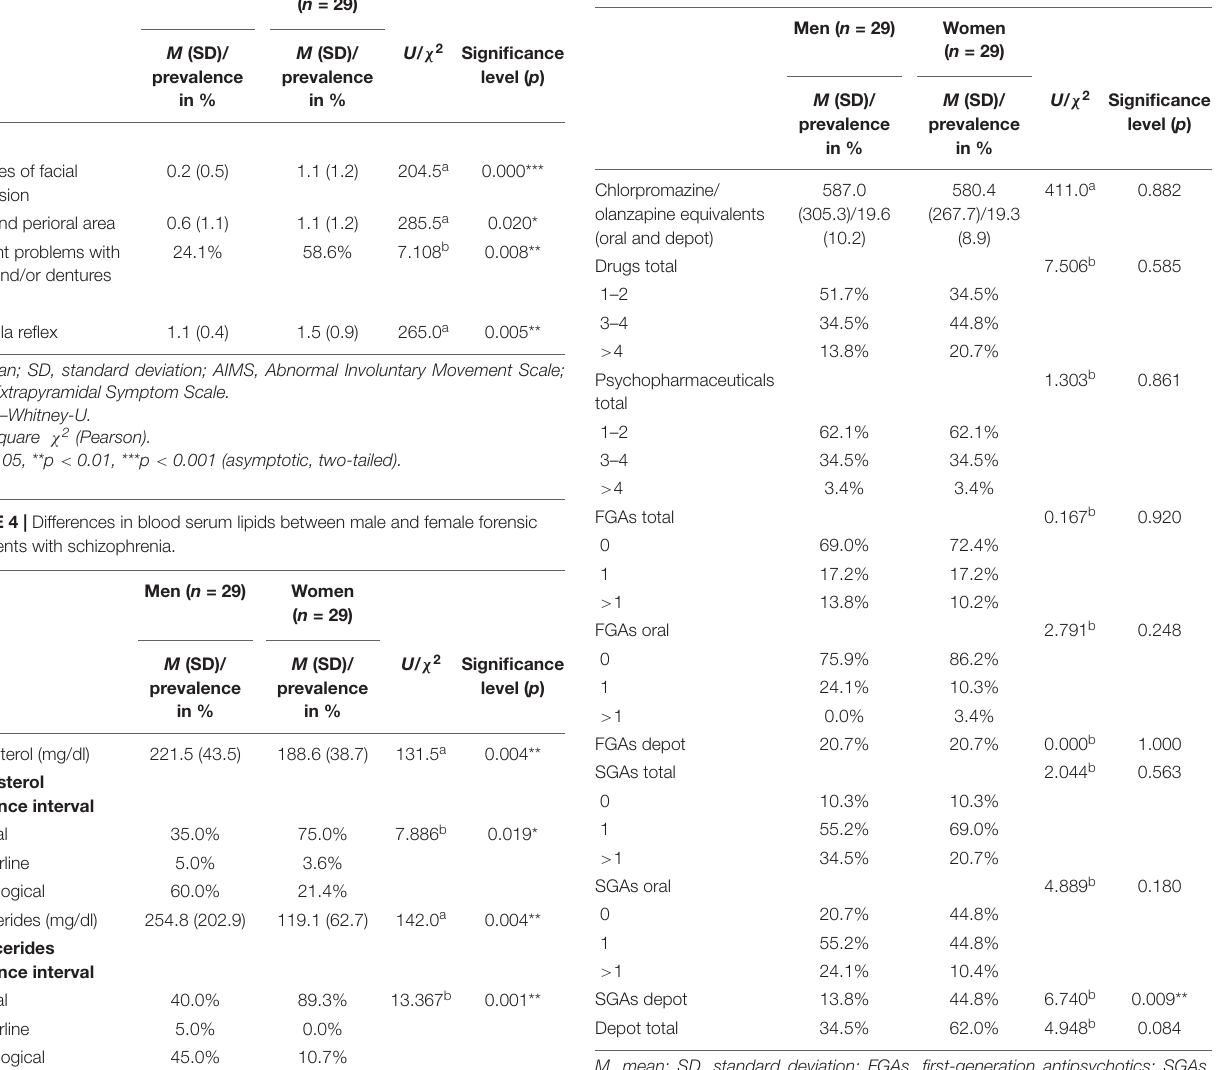
TABLE 5 | Prescription rates of psychopharmaceuticals in male and female forensic in-patients with schizophrenia, separated into first-generation antipsychotics (FGAs) and second-generation antipsychotics (SGAs) as well as oral and depot